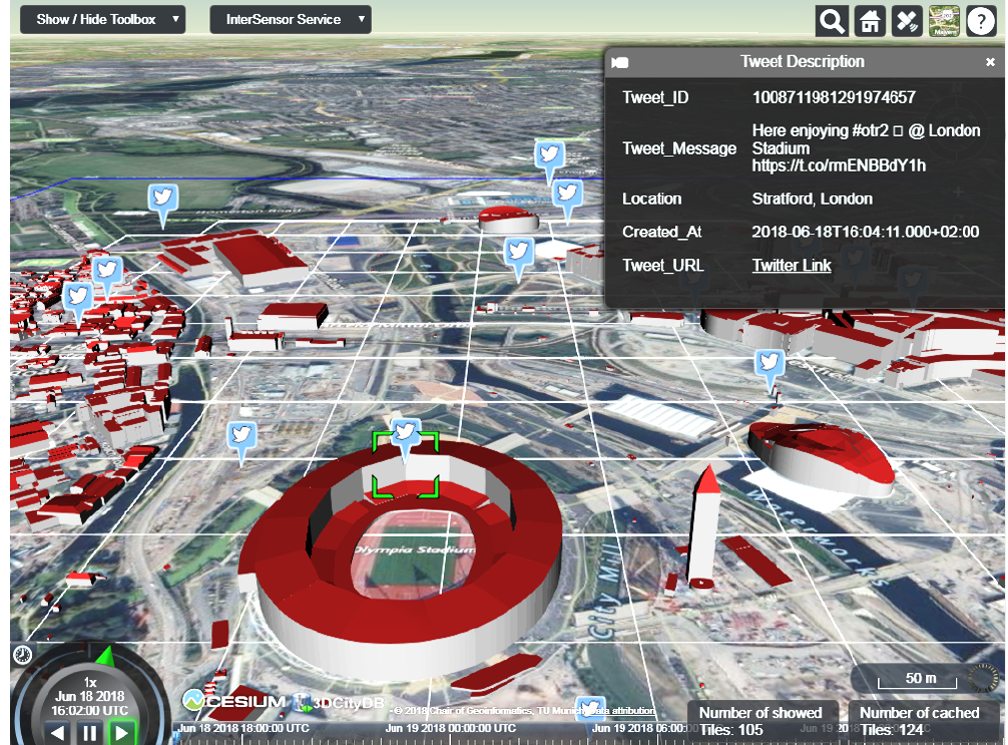
Figure 10. Joint visualization of geo-tagged tweets retrieved by the InterSensor Service along with CityGML-based 3D building objects in the district Queen Elizabeth Olympic Park, London. Screenshot taken from 3DCityDB-Web-Map application [91].